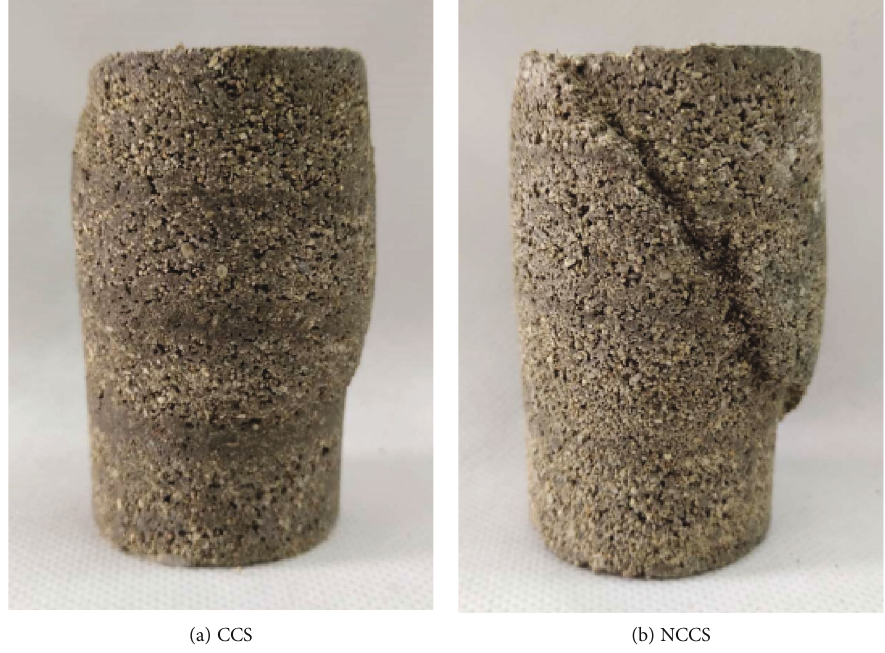
Figure 7: Failure characteristics of